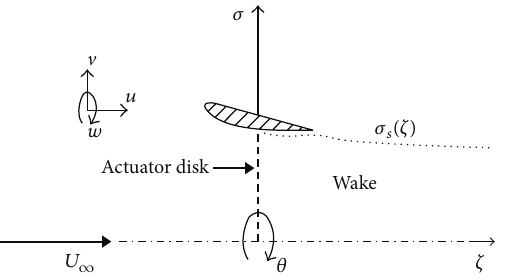
Figure 1: Schematic representation of the actuator disk flow prob-